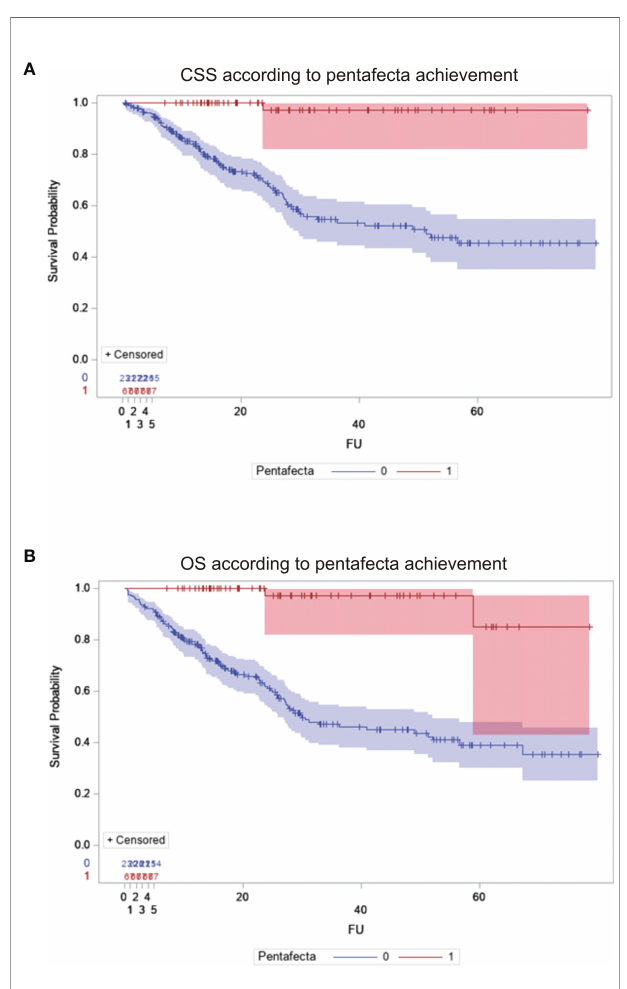
FIGURE 1 | Survival of patients undergoing radical cystectomy: comparison between patients who achieved and those who failed to achieve RC-pentafecta. (A) Cancer-speci fi c survival. (B) Overall survival. Blue line, pentafecta failers; red line, pentafecta